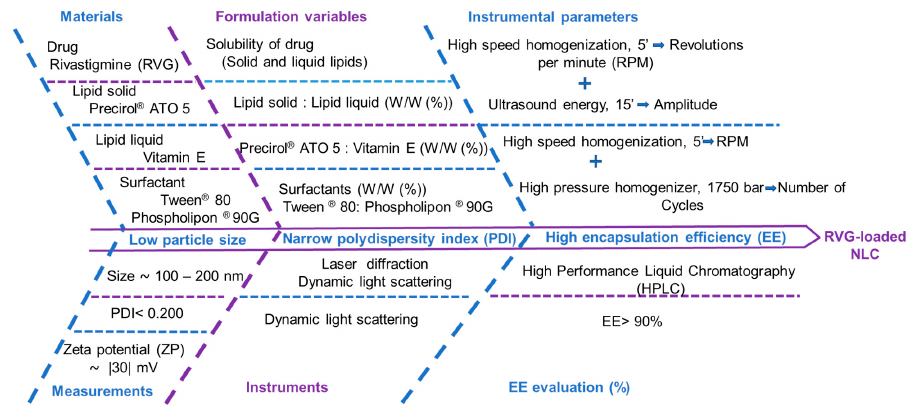
Figure 1. Ishikawa diagram showing the effects of critical material attributes (CMAs) and critical process parameters (CPPs) on the critical quality attributes (CQAs) of rivastigmine-loaded NLC formulation.